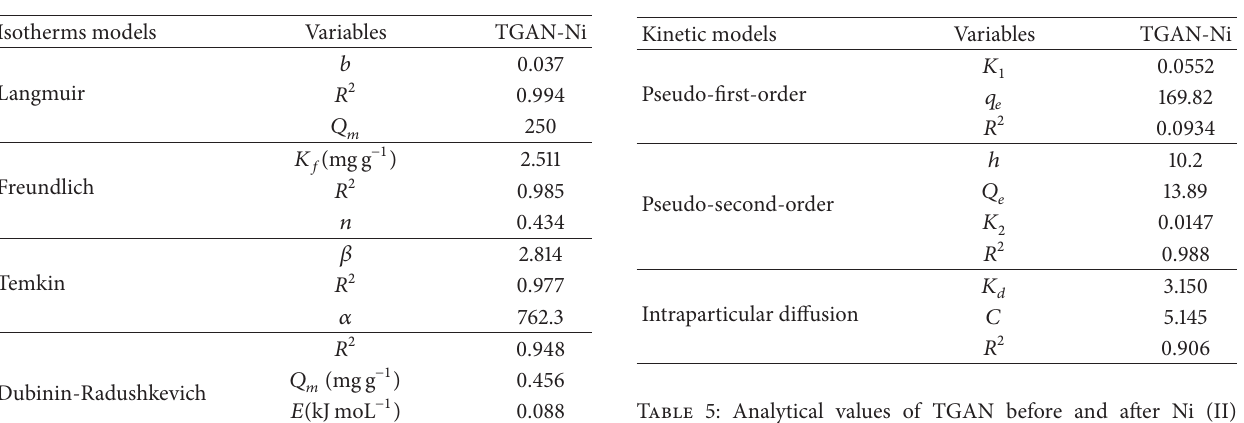
Table 3: Adsorption isotherm parameters for the adsorption of Ni (II) ions.